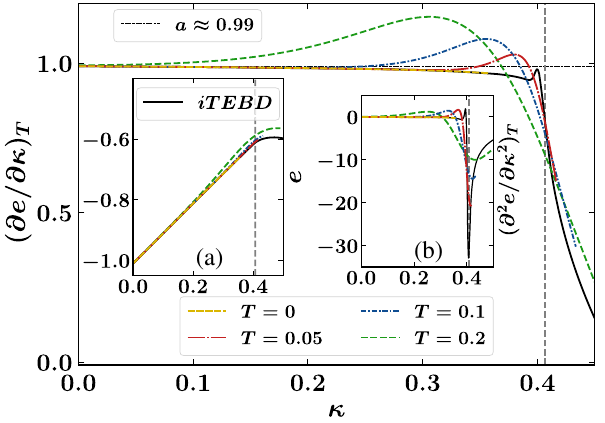
FIG. 9. Thermal equilibrium energy per site e and its deriva- tives at different T . The main figure shows ð ∂ e= ∂ κ Þ T , inset (a) shows e versus κ at constant temperature, and inset (b) shows T (the main ð ∂ 2 e= ∂ κ 2 Þ T . Results are shown for different values of figure and the insets share the legend). The solid (black) curve ( T ¼ 0 ) shows the iTEBD results for the ground state, while the FIG. 10. (a) Equilibrium temperature T ð κ Þ and (b) dC x 1 =d κ in other curves show NLCE results. Also depicted in the main figure thermal equilibrium, after quenches κ I → κ from initial ground ˆ H ð κ =L ≈ 0 . 99 for T ≲ 0 . 1 . The vertical dashed Þ for three different values of κ is a ¼ h σ x i σ x i þ 2 i ˆ ρ states of I I I . The vertical dashed I lines mark the critical κ c ≈ 0 . 41 lines mark the critical κ c ≈ 0 . 41 .